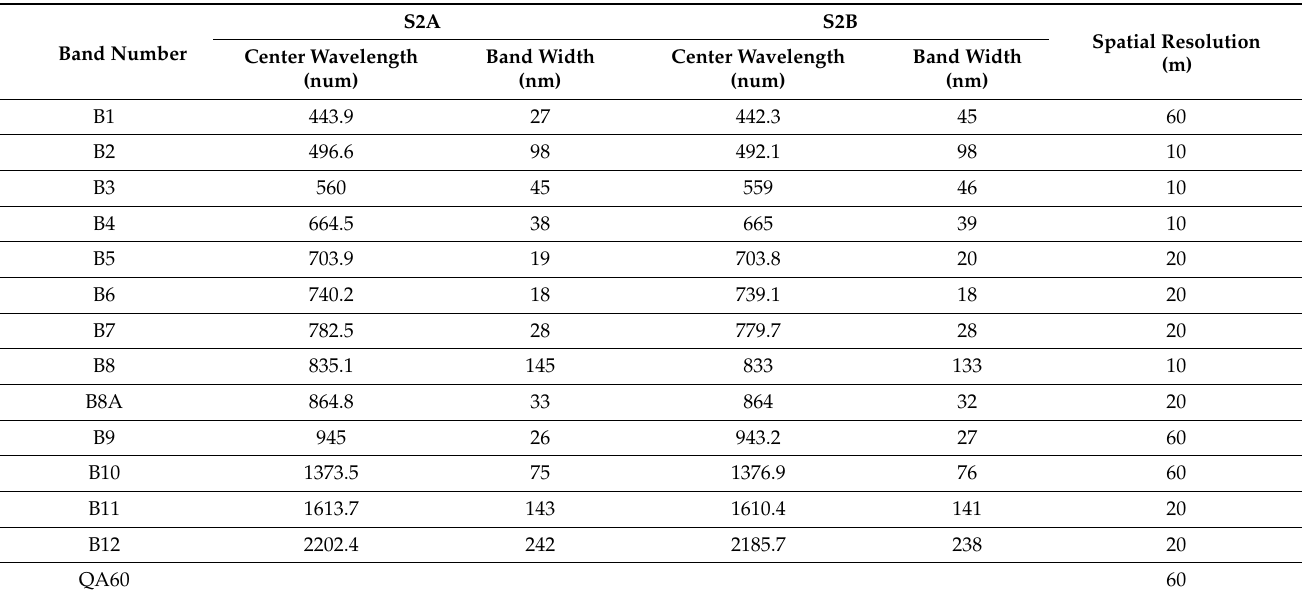
Table 1. Sentinel-2 Band